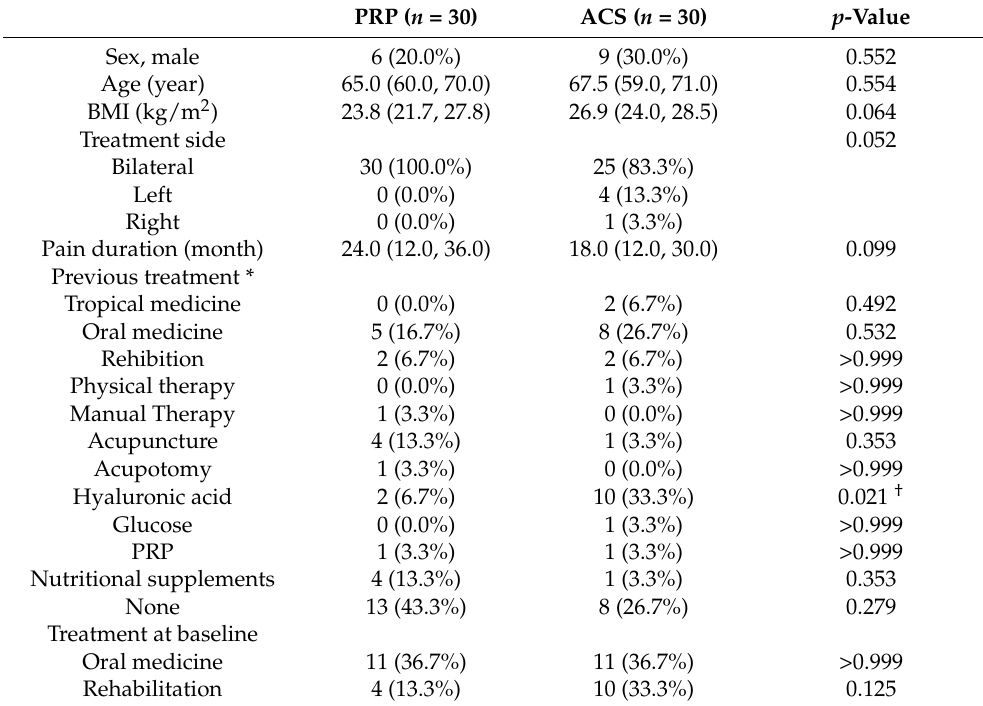
Table 1. Demographic and clinical characteristics in patients with Stage III osteoarthritis of the knee.